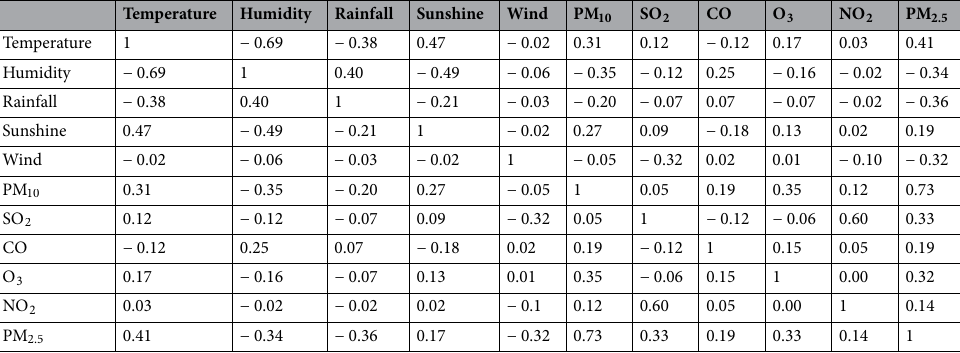
Table 1. Correlation